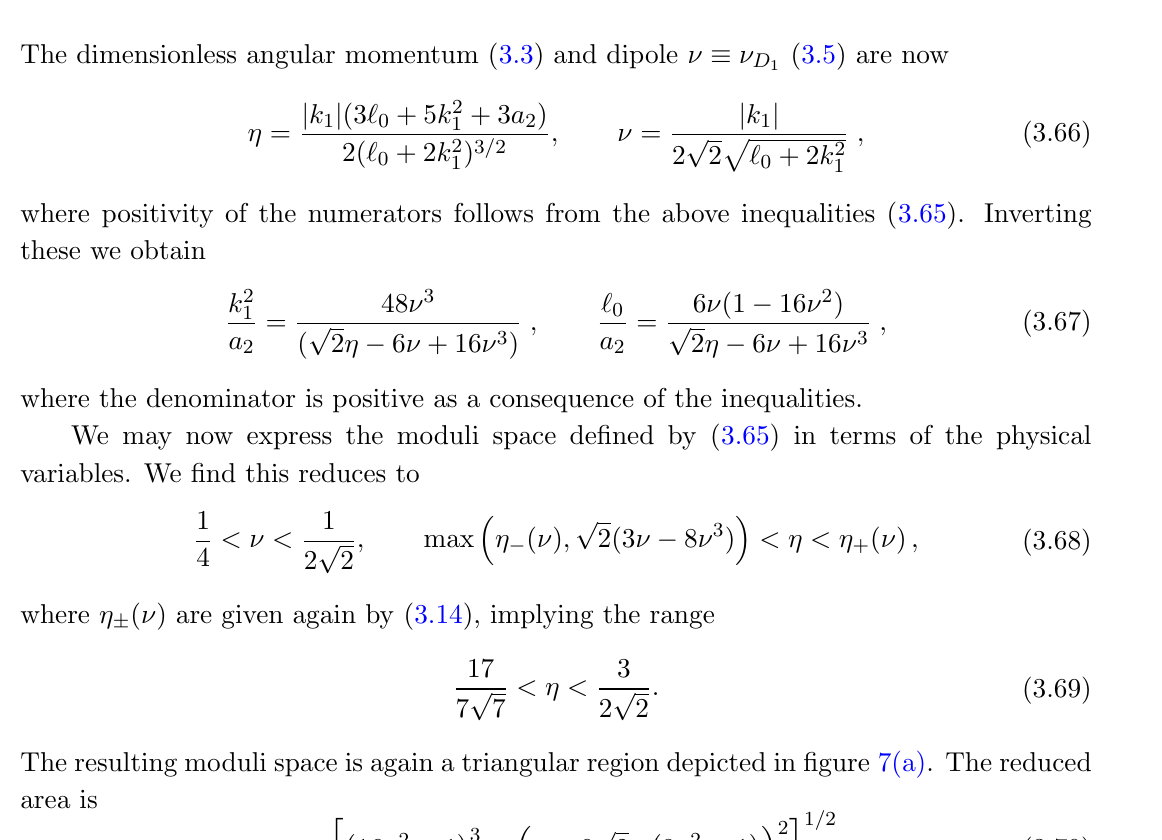
Figure 7. (a) Moduli space for the J (cid:30) = 0 spherical black hole III ( a 1 < 0 < a 2 , h 1 = 1, h 0 = (cid:0) 1, h 2 = 1). (b) Dimensionless area of the spherical black hole III (orange/lighter) and the BMPV black hole (blue/darker) within the region of overlap. Again a H > a BMPV in a narrow region close to (cid:17) =